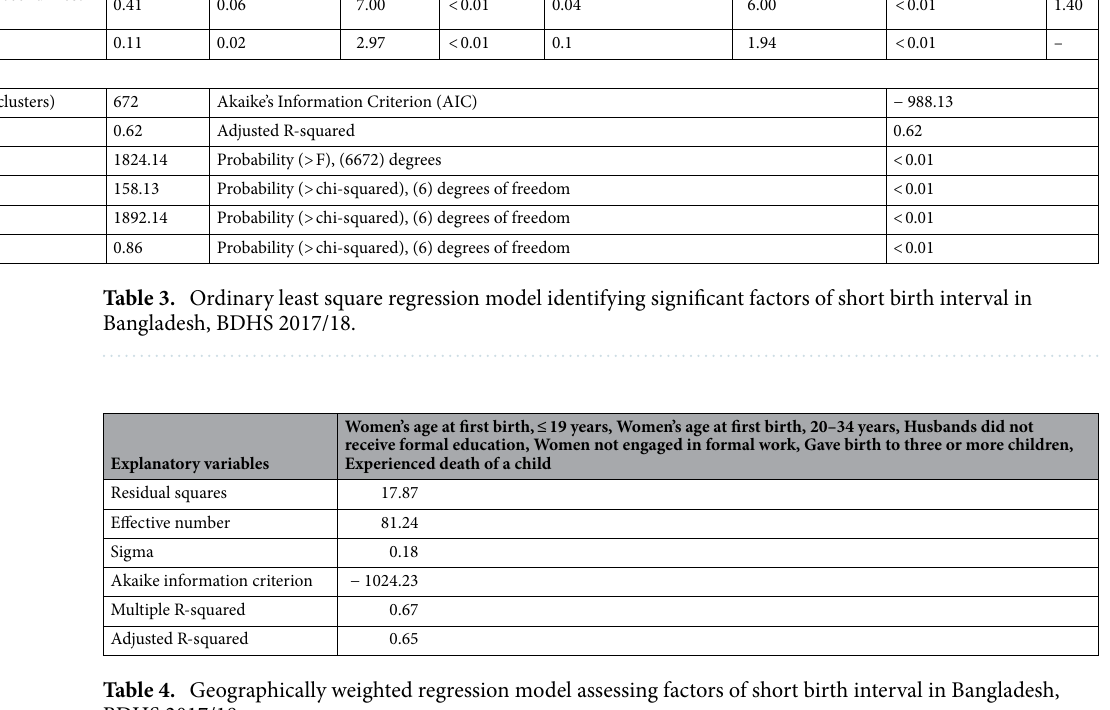
Table 4. Geographically weighted regression model assessing factors of short birth interval in Bangladesh, BDHS